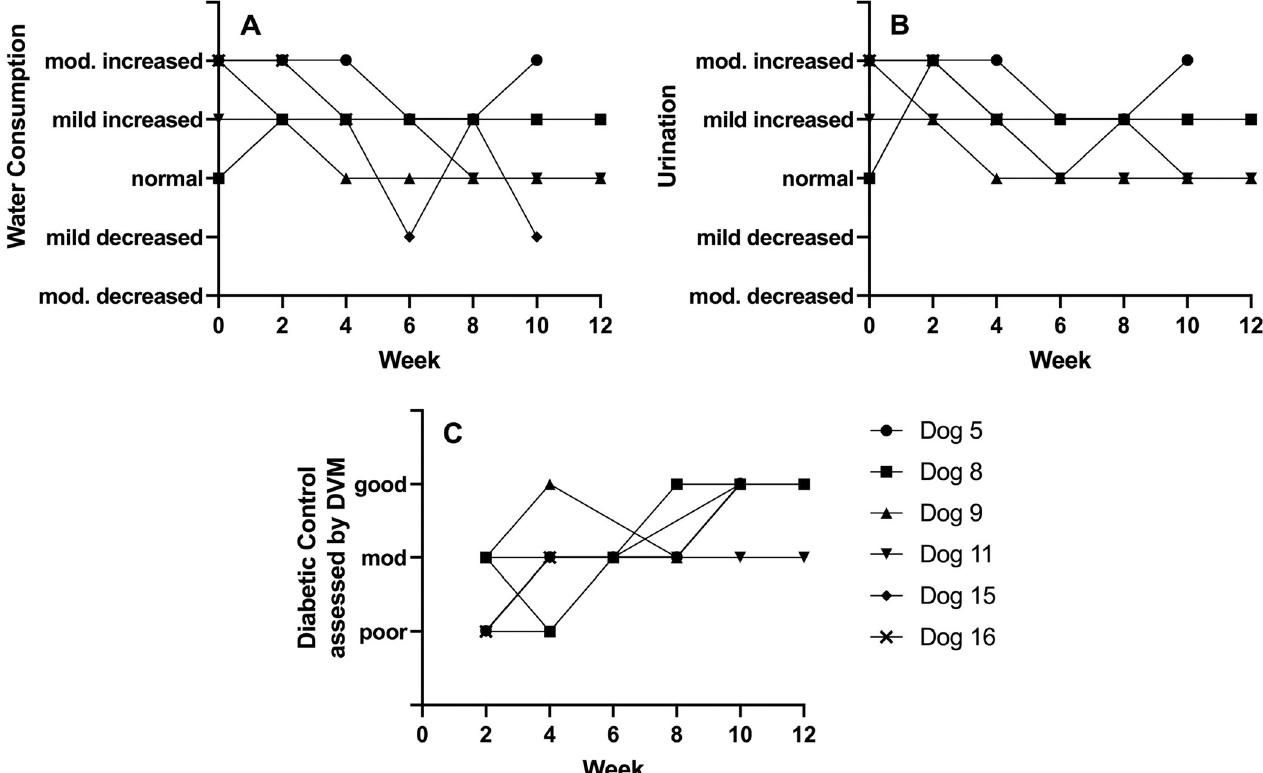
Fig 2. Subjective clinical measures of diabetic control. Subjective assessment of diabetic control over time including (A) water consumption assessed by owner, (B) urinary output assessed by owner, and (C) overall diabetic control assessed by primary veterinarian. mod = moderate.